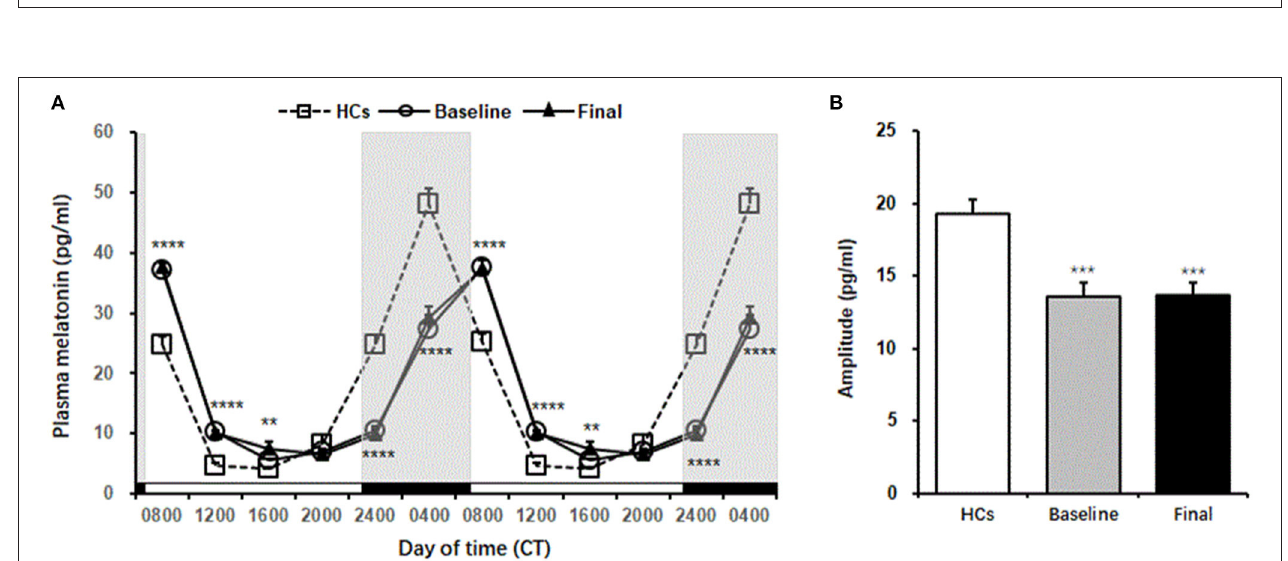
FIGURE 3 | Plasma melatonin levels in healthy controls and MDD patients. (A) The melatonin secretion rhythm, which is double-plotted. Shaded regions indicate nighttime. (B) Amplitude of melatonin in healthy controls and MDD patients. The data are expressed as mean ± SE. n = 13 MDD patients. n = 13 healthy controls. ** p < 0.01, *** p < 0.001, **** p < 0.0001, different from healthy controls. HCs, healthy controls; Baseline, MDD patients before treatment; Final, MDD patients at the end of 8 weeks of escitalopram treatment.